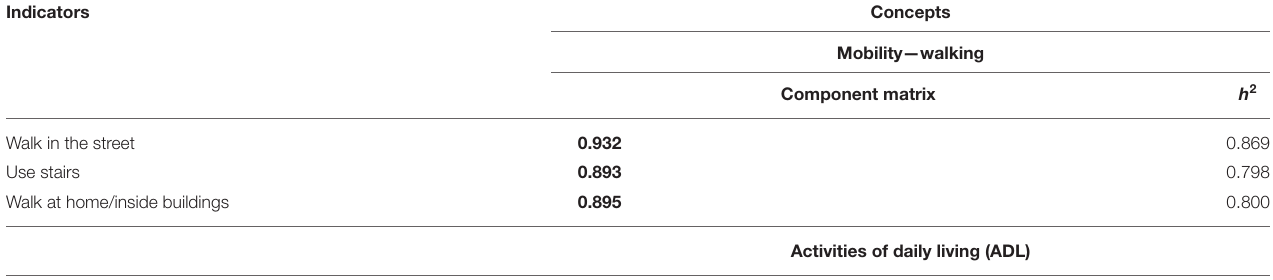
TABLE 2 | Analysis of the main components and the alpha coefficients ( N = 159,084).